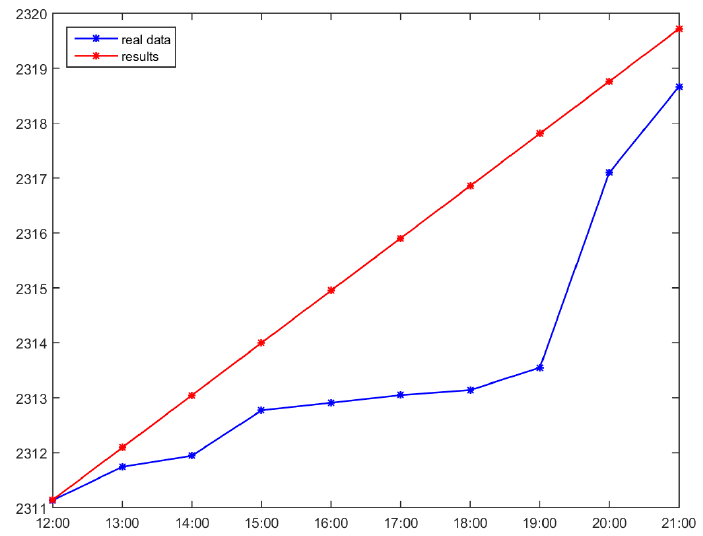
Figure 5. Comparison of linear interpolation results and real data.